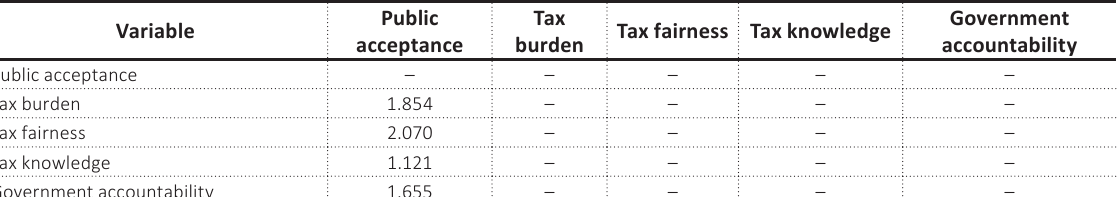
Table 6. Collinearity VIF